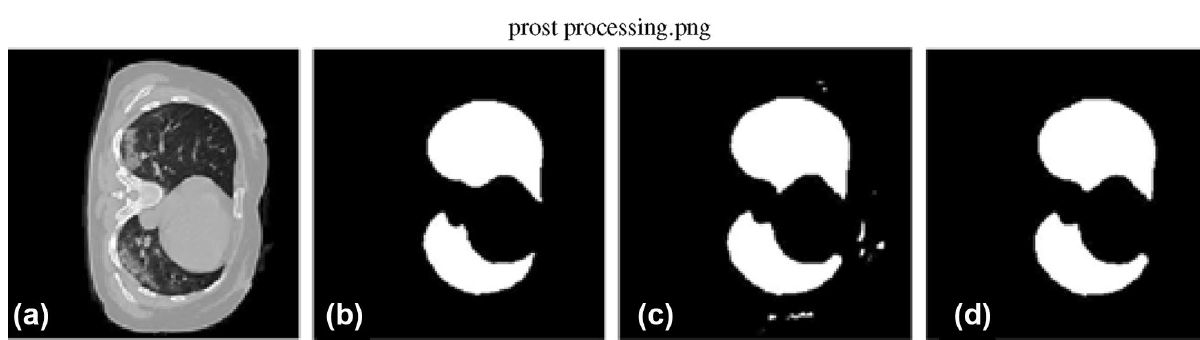
Figure 4. Lung parenchyma segmentation architecture.